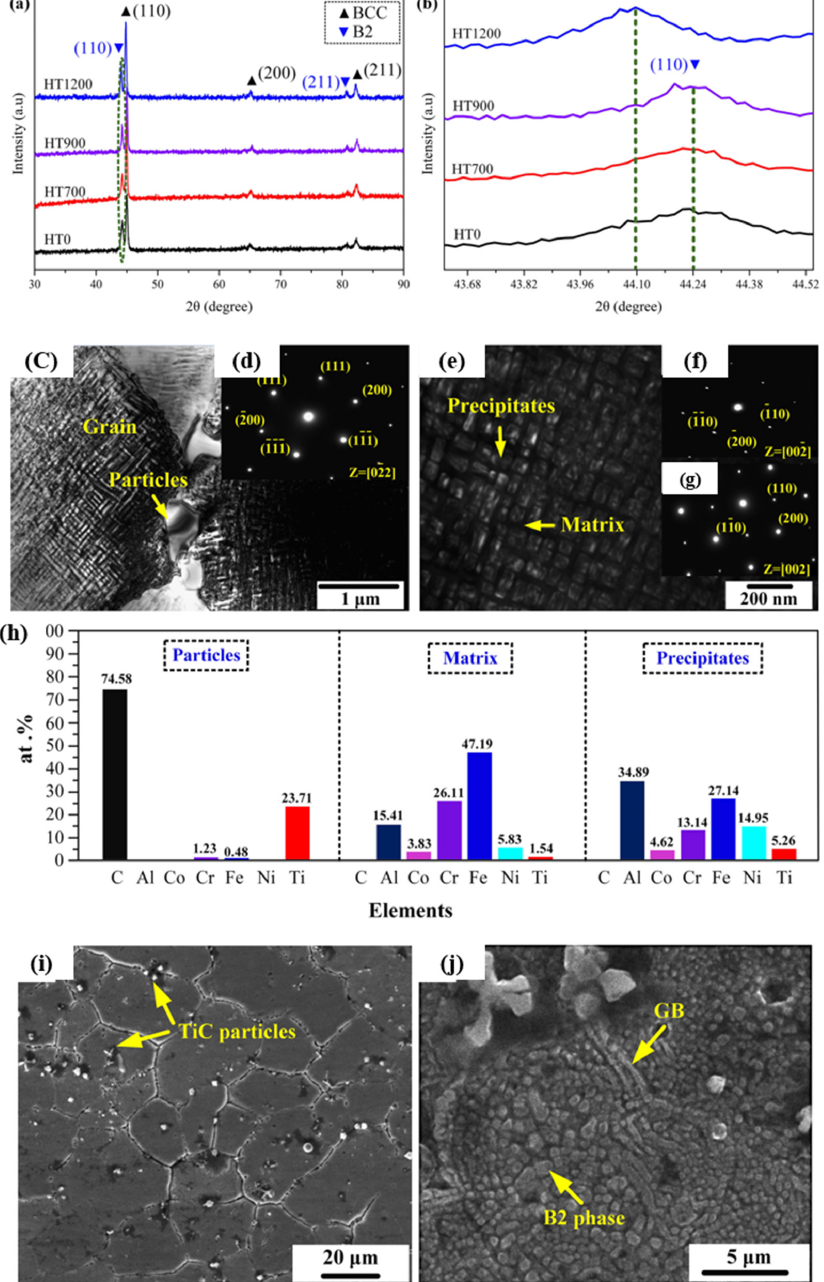
Figure 5. XRD patterns of the HEA coatings: ( a ) XRD patterns; ( b ) partial enlarged view; TEM and EDS results of the as-deposited coating: ( c ) TEM image; ( d ) SAED pattern of particles; ( e ) enlarged view of grain; ( f ) SAED pattern of matrix; ( g ) SAED pattern of nano-precipitates; ( h ) EDS results; ( i , j ) Cross-section SEM images of the HEA coating HT0. (Reprinted with permission from ref. [49]. Copyright 2020 Elsevier).